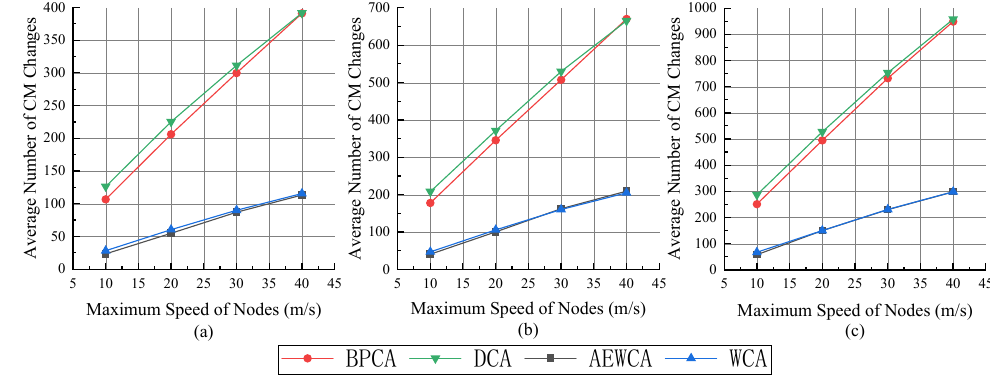
Figure 8. The effects of maximum movement speed on the average number of CM changes. ( a ) Number of nodes is 100; ( b ) number of nodes is 150; ( c ) number of nodes is 200. Figure 8 represents the relationship between the average number of CM changes and a node’s maximum movement speed. As can be seen in Figure 8, the average number of CM changes increases as the speed and the number of nodes increase. The average num- ber of CM changes in the BPCA scheme and DCA scheme is much higher than the average